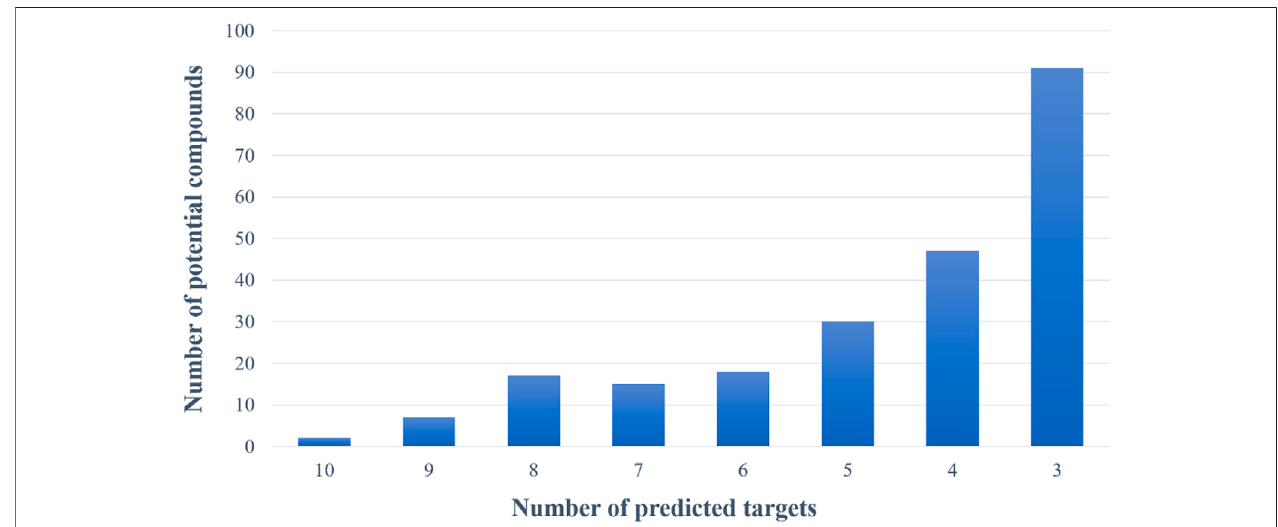
FIGURE 5 | The number of potential active chemical constituents and the number of their predicted targets.